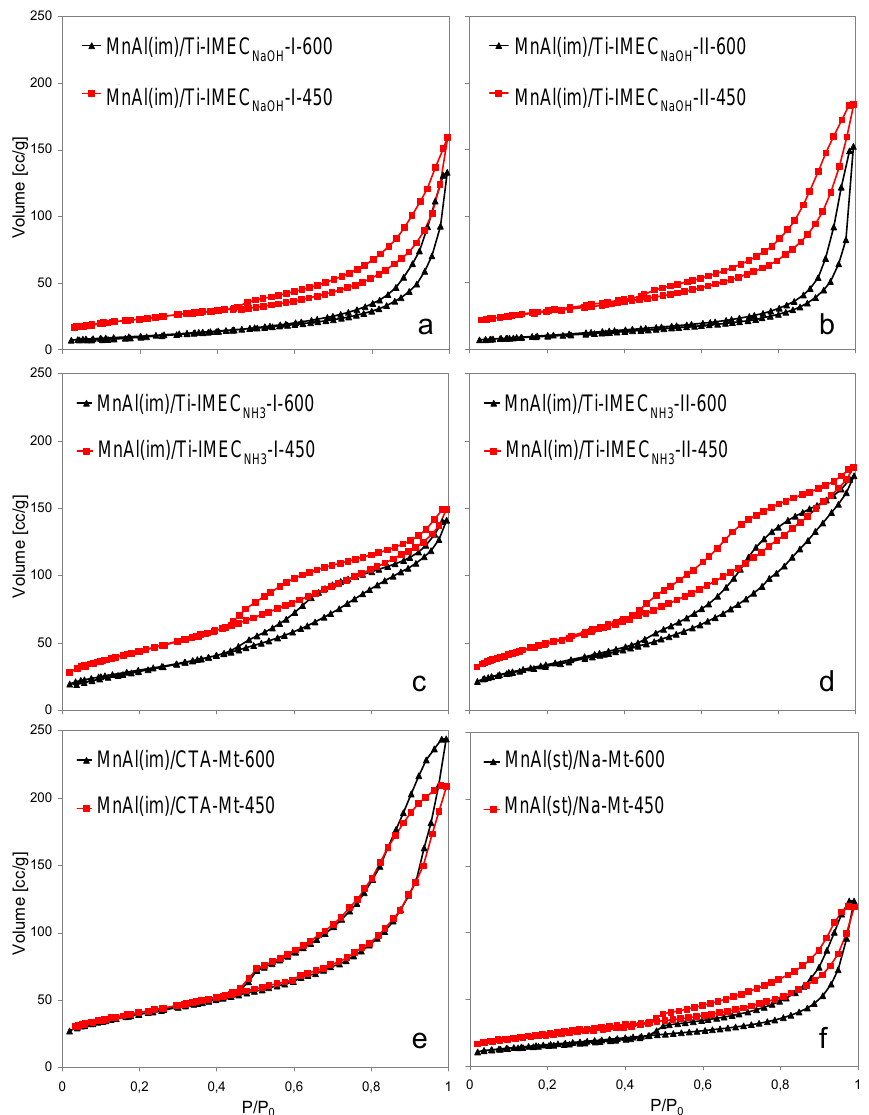
Figure 2. N 2 adsorption/desorption isotherms of investigated composites calcined at 450 and 600 °C, ( a ) MnAl(im)/Ti ‐ IMEC NaOH ‐ I; ( b ) MnAl(im)/Ti ‐ IMEC NaOH ‐ II; ( c ) MnAl(im)/Ti ‐ IMEC NH3 ‐ I; ( d ) MnAl(im)/Ti ‐ IMEC NH3 ‐ II; ( e ) MnAl(im)/CTA ‐ Mt; ( f ) MnAl(st)/Na ‐ Mt.